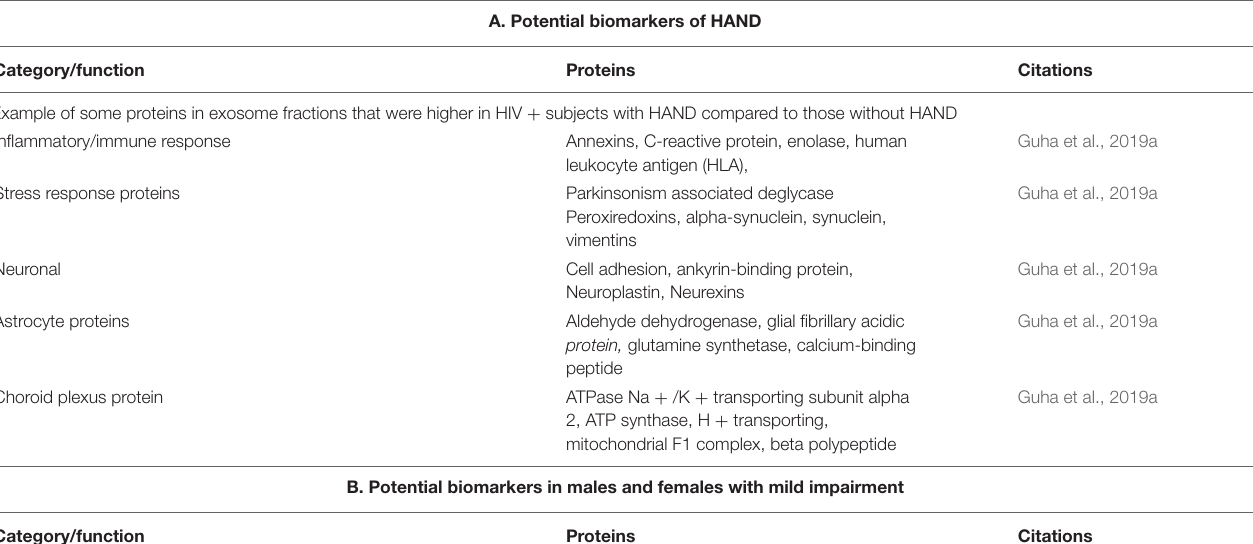
TABLE 1 | (A) Potential Biomarkers of HAND; (B) potential biomarkers in males and females with mild